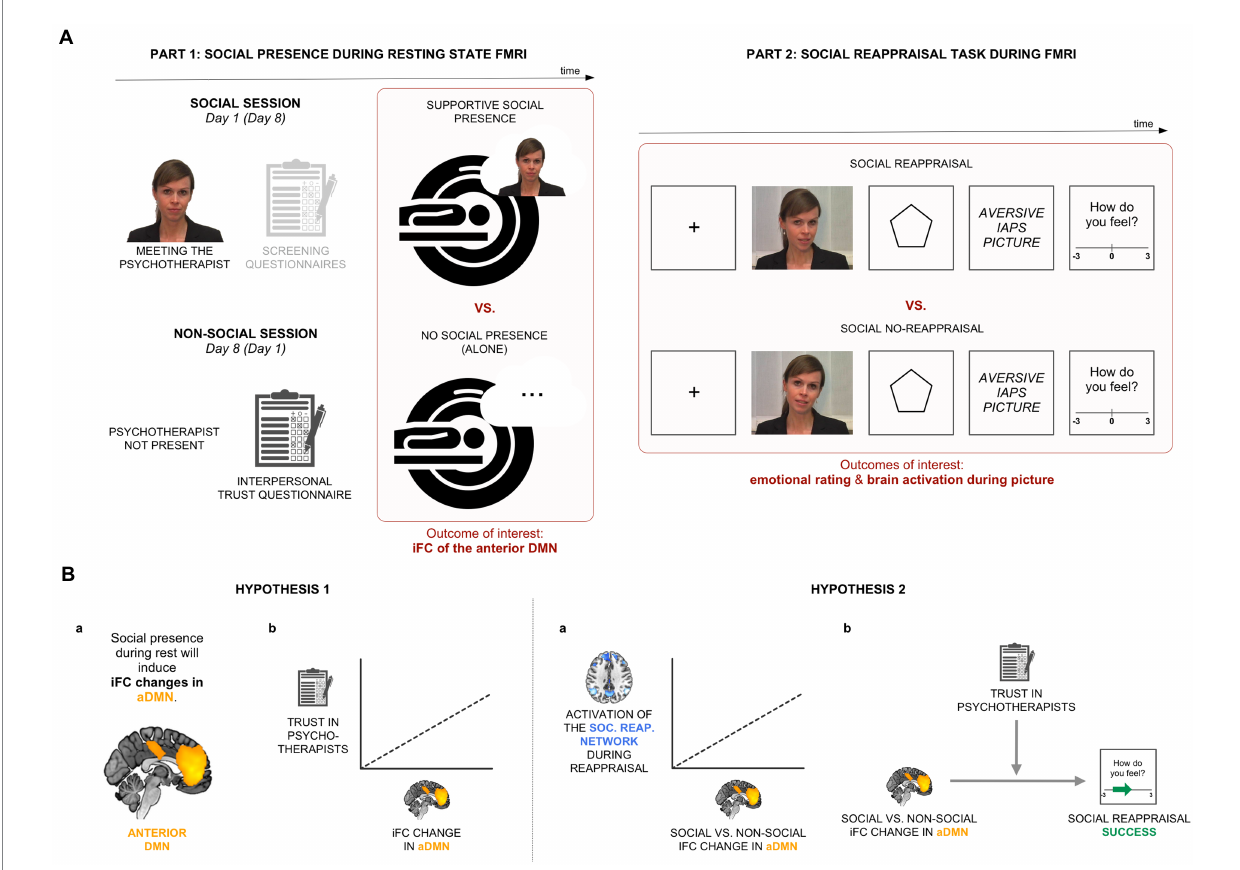
FIGURE 1 Experimental design and hypotheses. (A) In Part 1 of the experiment, we recorded participants’ brain activity in two resting-state conditions, alone and in the condition of perceived supportive presence of a psychotherapist. Part 2 involved a social reappraisal task with aversive pictures as negative stimuli. (B) Hypothesis 1: We hypothesized that iFC of the anterior medial default mode network (aDMN) will be sensitive to the psychotherapist’s presence (Hypothesis 1a) and that the effect will be related to general trust in psychotherapists (Hypothesis 1b). Hypothesis 2: We expected a positive relationship between the social presence-induced iFC change during rest and brain activations within the social reappraisal activation network (Hypothesis 2a). We further hypothesized a positive relationship between the social presence effect in the aDMN and social reappraisal success, moderated by trust in psychotherapists (Hypothesis